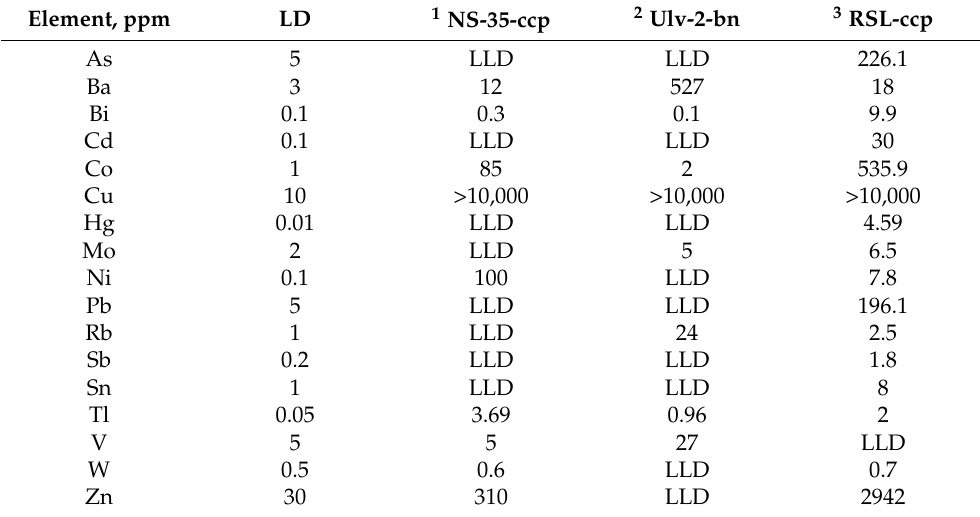
Table 2. Lithogeochemistry of hand-picked chalcopyrite from the Nussir deposit (NS-35-ccp), bornite from the Ulveryggen deposit (Ulv-2-bn) and chalcopyrite Røros Mine (RSL-ccp). Element,